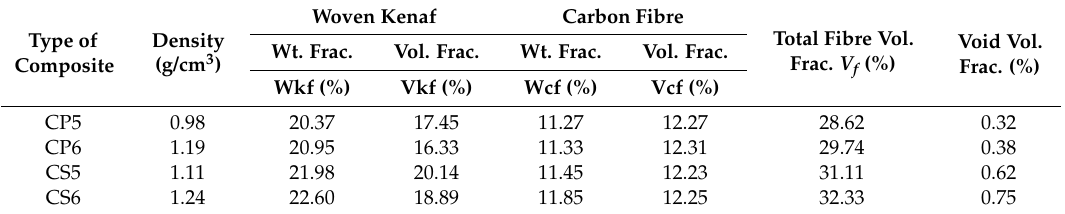
Table 4. Composite density and volumetric composition of woven kenaf/carbon fibre hybrid composite. Type of Composite